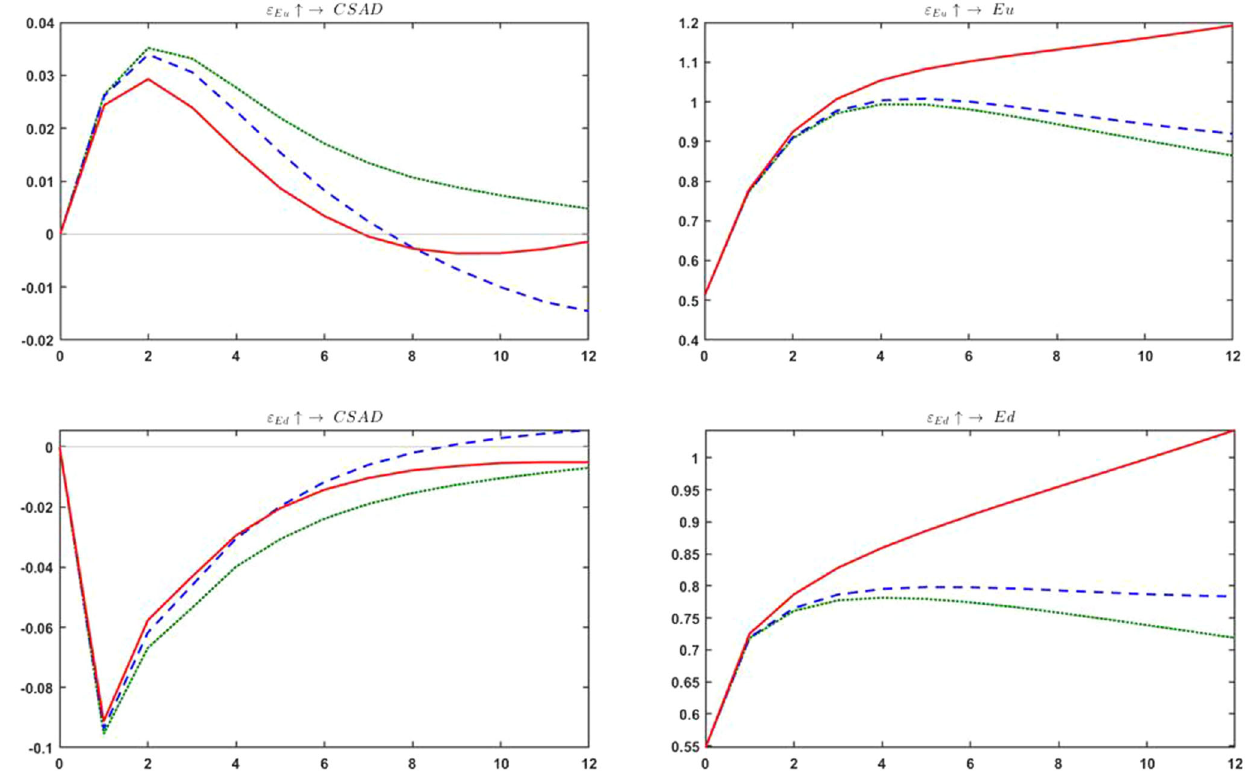
Fig. 4 Impulse responses at different time points. The responses of market dispersion and internet postings to a unit shock in increasing postings or decreasing postings at different time points.